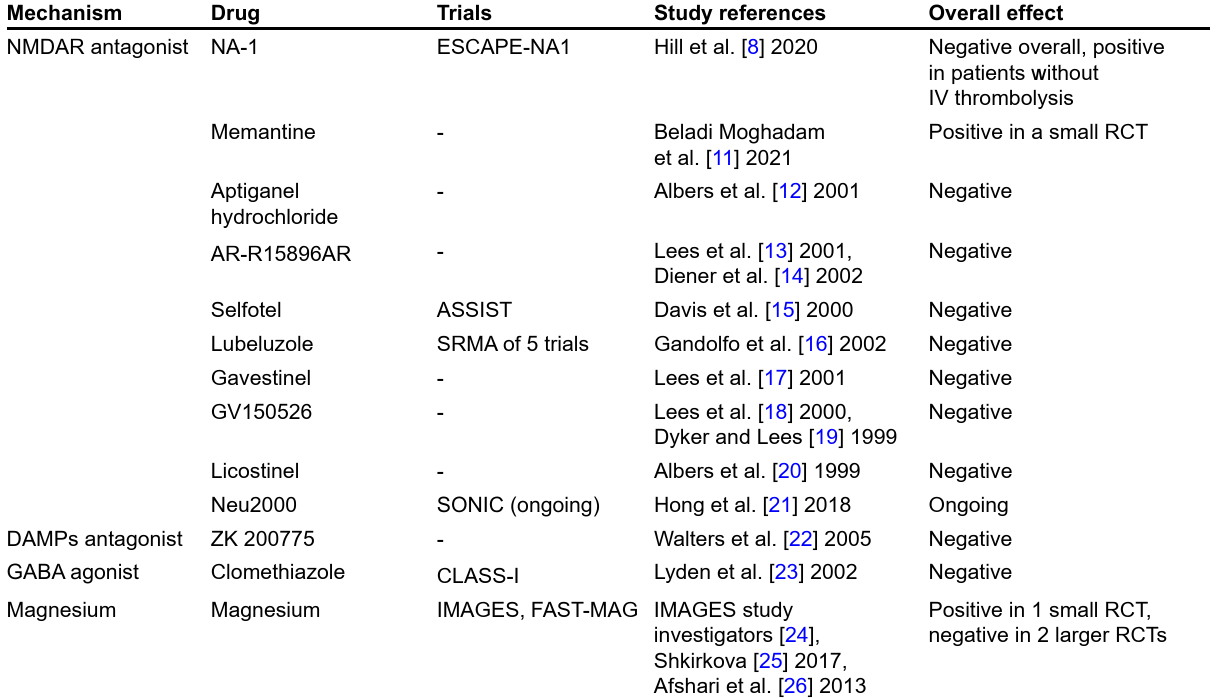
Table 1. Overview of human trials on neuroprotective agents in AIS Mechanism